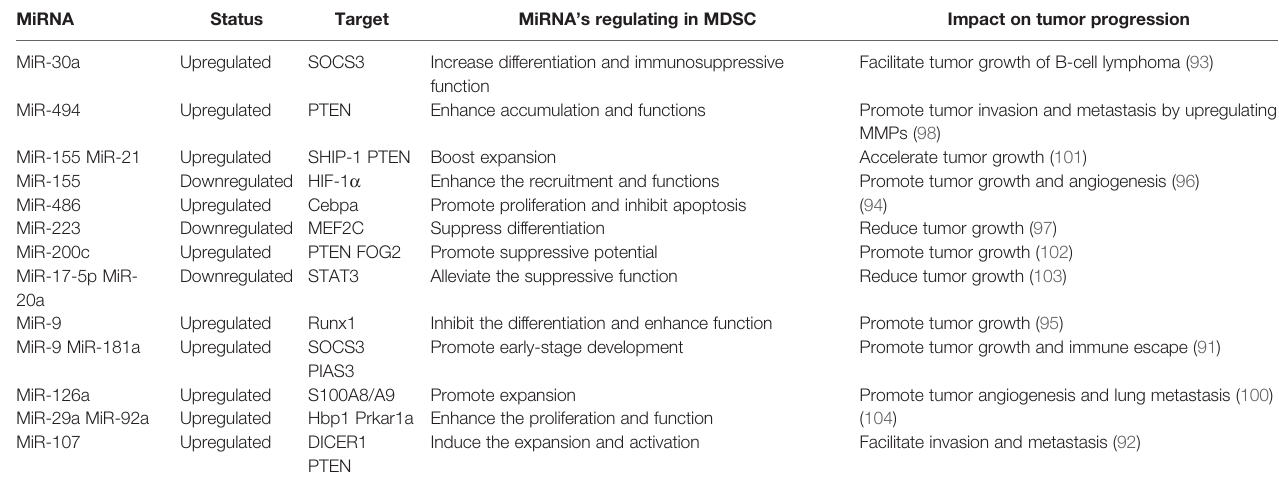
TABLE 3 | MiRNA related with MDSC in tumor